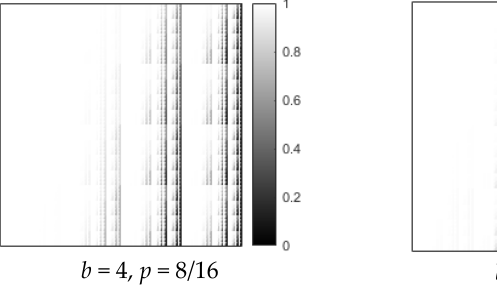
Figure 7. Multifractal porous materials synthesized by the two-parameter binomial multiplicative cascades.